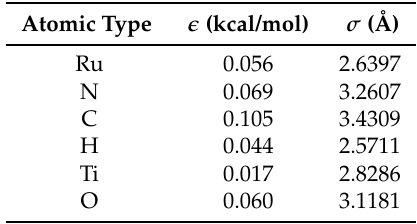
Table A1. Lennard-Jones parameters used